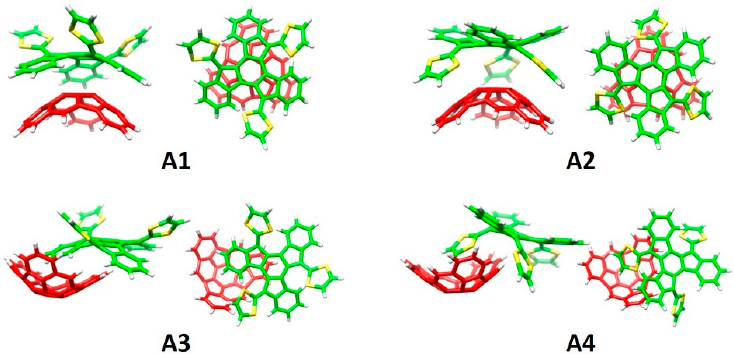
Figure 16. Minimum-energy structures ( A1 – 4 ) computed for the truxTTF•C 30 H 12 heterodimer at the revPBE0-D3/cc-pVTZ level. For C 30 H 12 , the carbon and hydrogen atoms are depicted in red and white, respectively. For truxTTF, the sulfur, carbon and hydrogen atoms are colored in yellow, green and white, respectively.